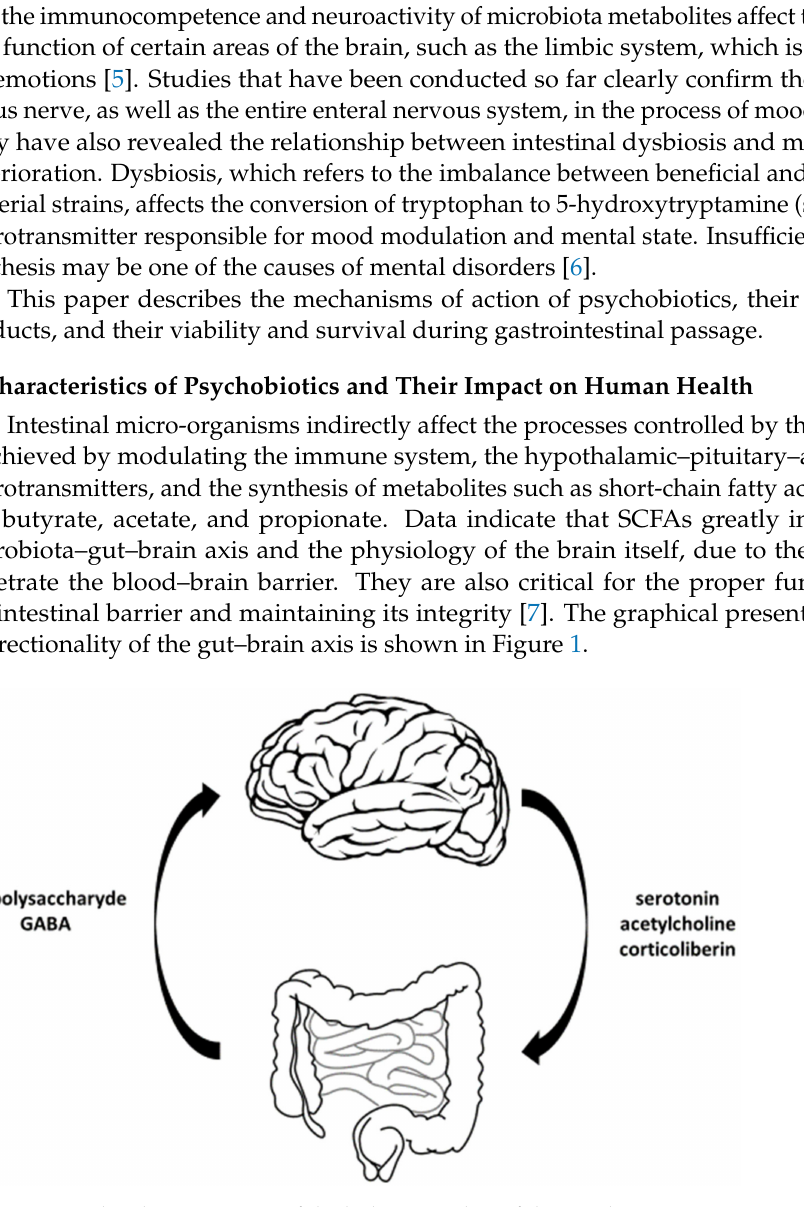
Figure 1. Graphical presentation of the bidirectionality of the gut–brain